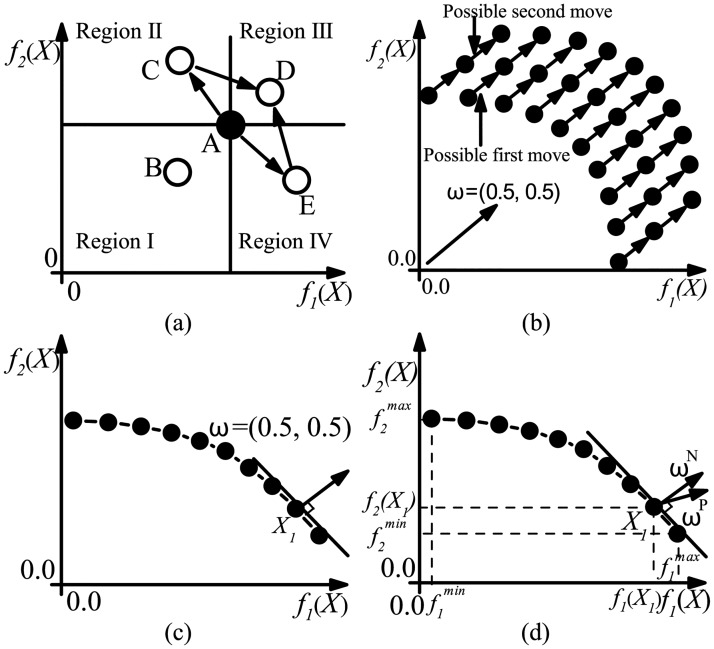
Illustration of possible designs of fitness evaluation method for local search procedure.(a) Region I-IV are four regions divided with respect to node A. Individuals in region I dominate A and in region I,II,IV are not dominated by A. Region I is too small to search, while individuals in region II and IV may move to Region III which are dominated by A after several generations; (b) When constant weight vector ω = (0.5,0.5) is applied, individual population will suffer from diversity problem after several searches; (c) Assuming weight vector ω = (0.5,0.5) selects X
1 as initial individual according to random weight vector scheme, then the probability to select right side individual is much higher then select left side as there is only one individual on the right side of X
1; (d) Pseudoweight vector ω
P deviates from normal line vector ω
N.